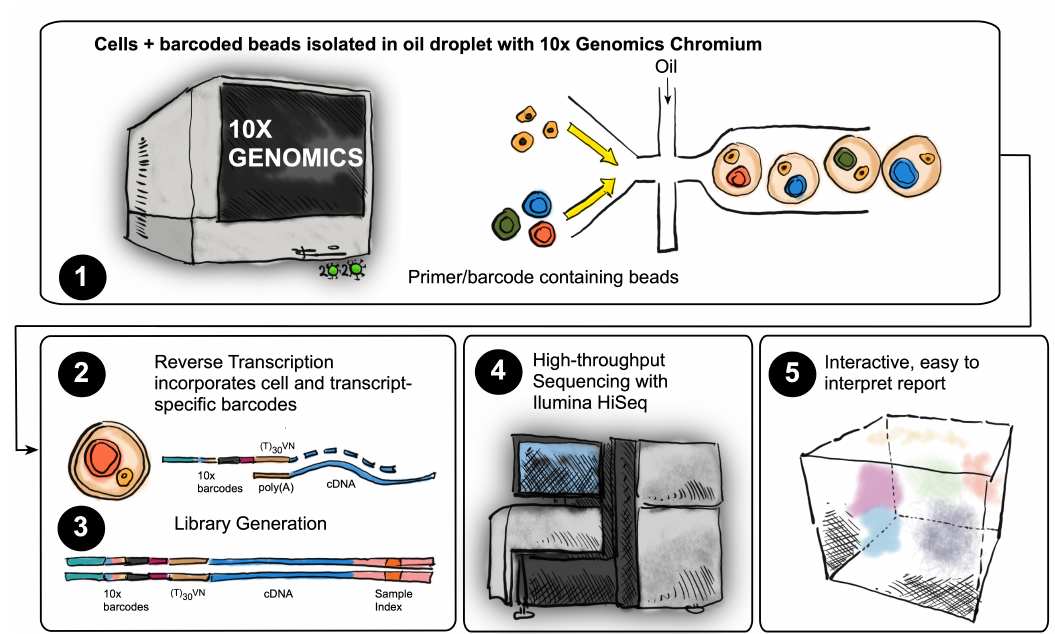
Figure 13. 10 × single-cell sequencing workflow. Single-cell RNA-seq workflow. ( 1 ) Isolated single NP or AF cells together with barcoded beads and reverse transcription reagents were isolated in oil droplets using the 10 × Genomics Chromium system ( 2 ) Within each micro reactor, the single cell were lysed, and reverse transcription of polyadenylated mRNA occurs with the incorporation of cell-specific and transcript specific barcodes or UMIs (Unique Molecular Identifier). ( 3 ) As a result, all cDNAs from a single cell had the same barcode, which enabled the sequencing reads to be clustered together. Next generation sequencing (NGS) libraries from these barcoded cDNAs were prepared. ( 4 ) NGS was performed in a Novaseq 6000 system. ( 5 ) Cell Ranger (v3.0.1) was used to align the reads to the reference genome and generate count tables of UMIs for each gene per cell. Subsequent data analysis steps were performed as described in Section